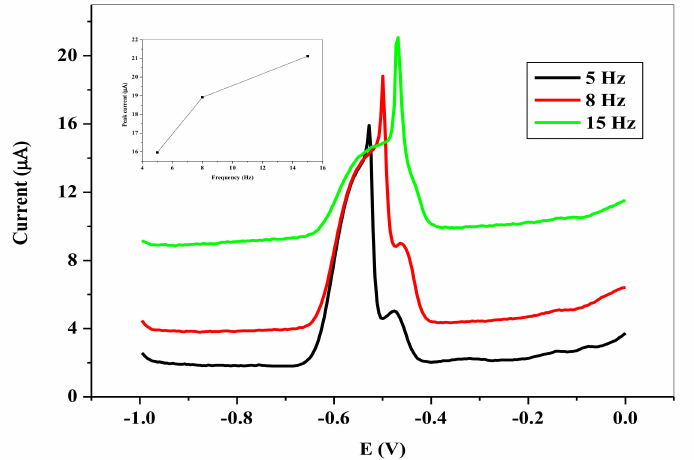
Figure 13. SWVs showing influence of frequency on the stripping peak current of 6.0 × 10 − 5 M Pb 2+ in 0.1 M HCl electrolyte on SPCE/OPE/BIONPs/PANI, 1200 mV deposition potential, 180 s deposition time, (Potential vs. Ag/AgCl).